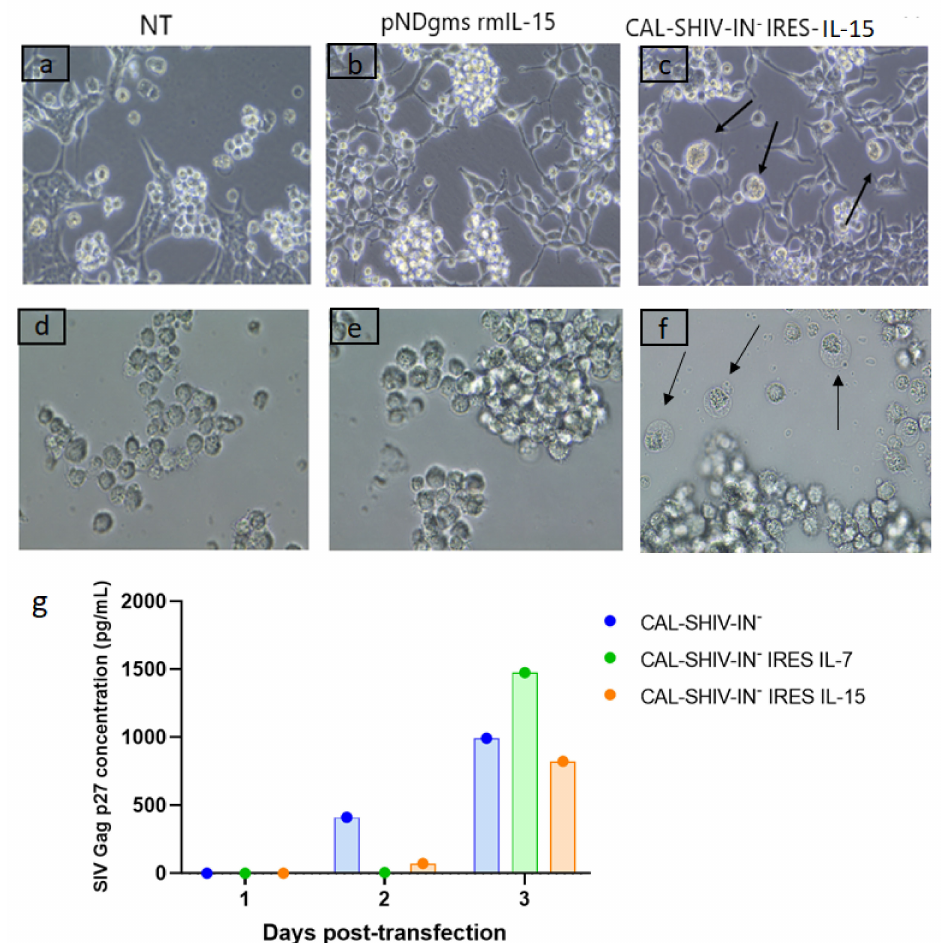
Figure 1. Functional expression of SIV proteins. Co-culture of permissive M8166 lymphocyte cells with HEK 293T cells non-transfected ( a ), transfected with pNDgms-rmIL-15 ( b ) or transfected with CAL-SHIV-IN − IRES-cytokines ( c ). CPEs were observed in the cultures with the CAL-SHIV-IN − IRES-cytokines (black arrows). Supernatants of HEK 293T cells in ( a – c ) were used to inoculate cultured M8166 in ( d – f ), respectively. At 24 h post-inoculation, CPEs were observed only in ( f ) (black arrows). ( g ) Quantification of SIV Gag p27 by ELISA: Supernatants of HEK 293T cells in a, b and c harvested at days 1, 2 and 3 post-transfection were analyzed by ELISA. Results were expressed in